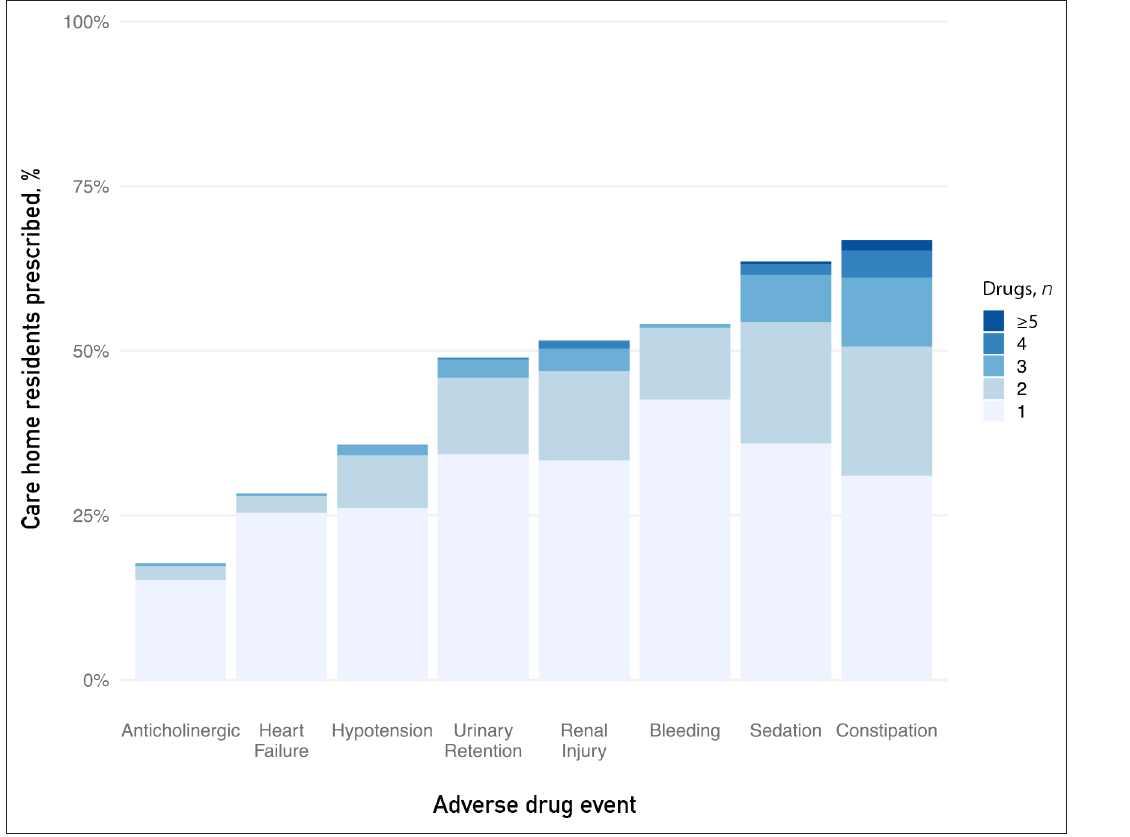
Figure 2 Percentage of care home residents prescribed drugs associated with eight common adverse drug events